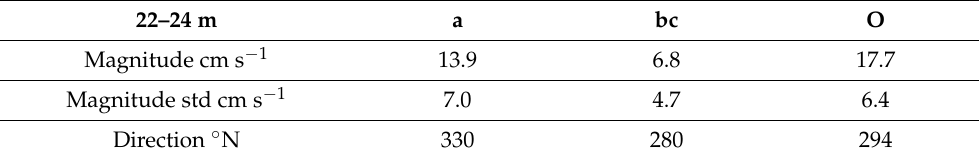
Table 3. Temporal averaged magnitude with standard deviation and direction of currents at the cell including 22–24 m depth. Letter a stands for current measurements collected in 2004, while bc indicates the two time series merged for year 2005. O indicates the ADCP measurements from the spar